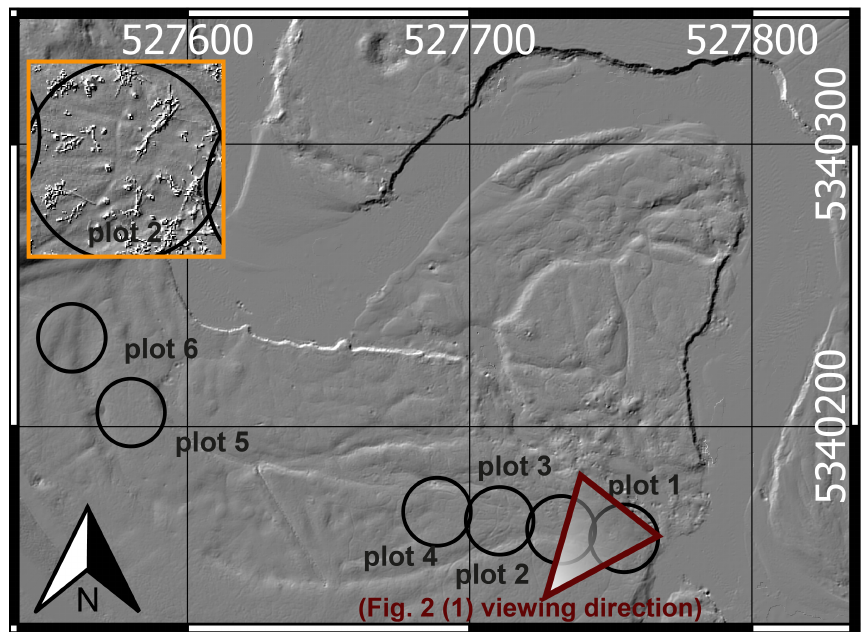
Figure 4. Shading of the DTM derived by the ULS data. DTM resolution 15 cm. The orange box shows a zoom of the near ground DEM shaded relief map for plot 2. The viewing direction of Figure 2 (1) is marked in